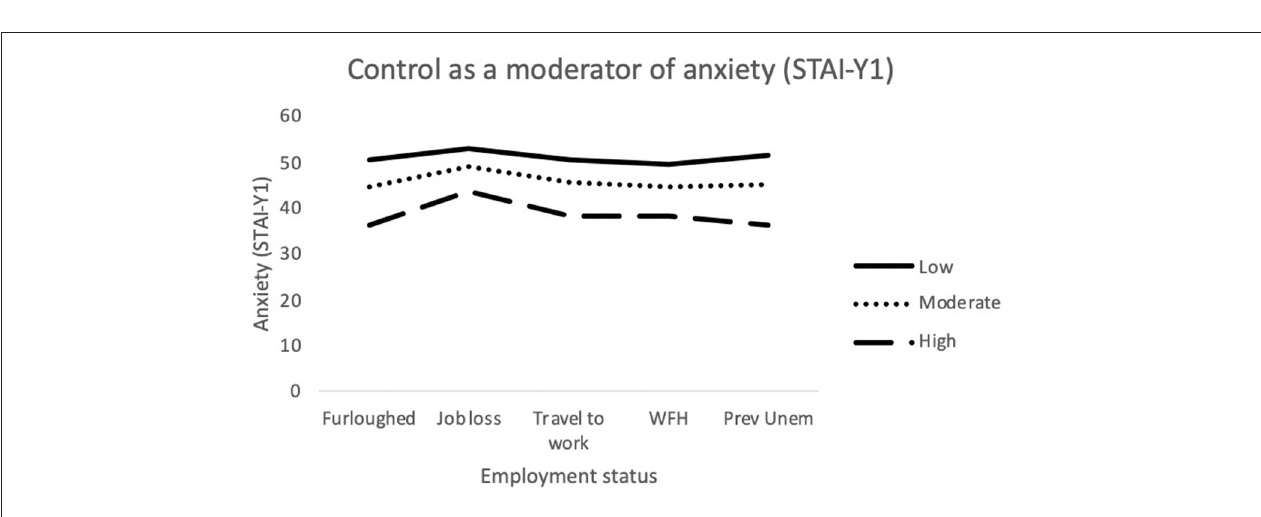
FIGURE 1 | Interaction between job outcome and Challenge for State Anxiety. WFH , Employed (working from home); Prev Unemp , previously unemployed.